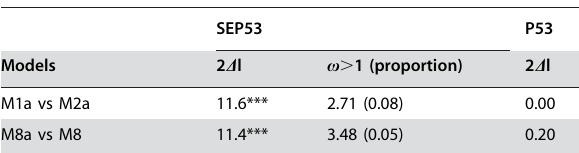
Table 1. The stress response protein SEP53 evolves rapidly through positive natural selection as evidenced by an